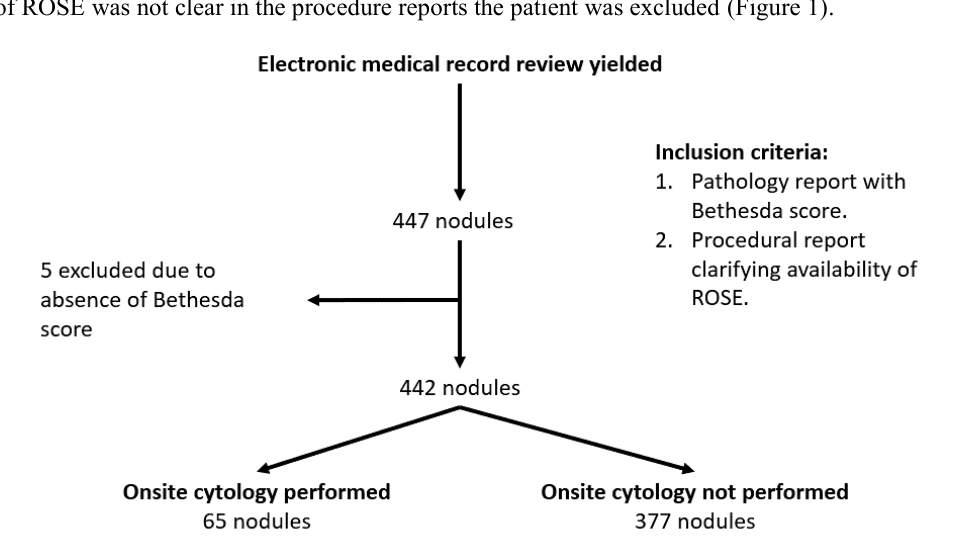
Figure 1. Flowchart highlighting study design and patient selection